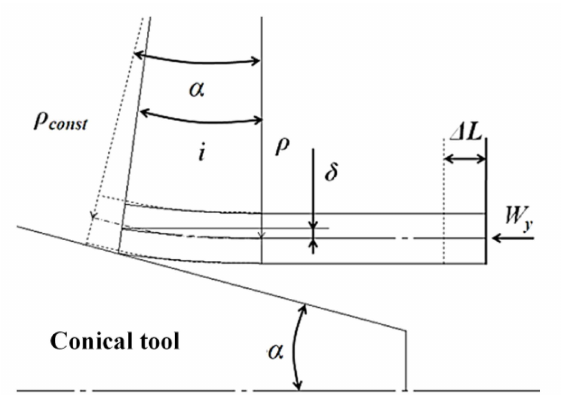
Figure 9. Simple model for deformation part of flaring test.